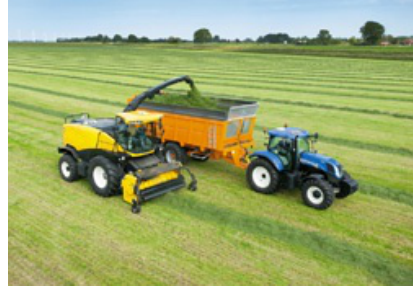
Figure 10. Combine harvester machine in a conventional loading